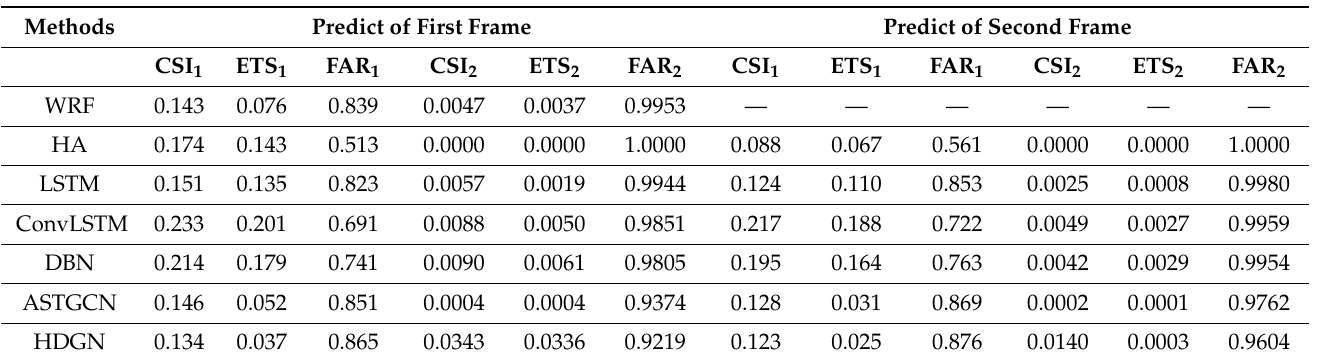
Table 5. Short-term intensive rainfall prediction performance of the baseline and proposed methods on the S-WRF dataset in the future first and second